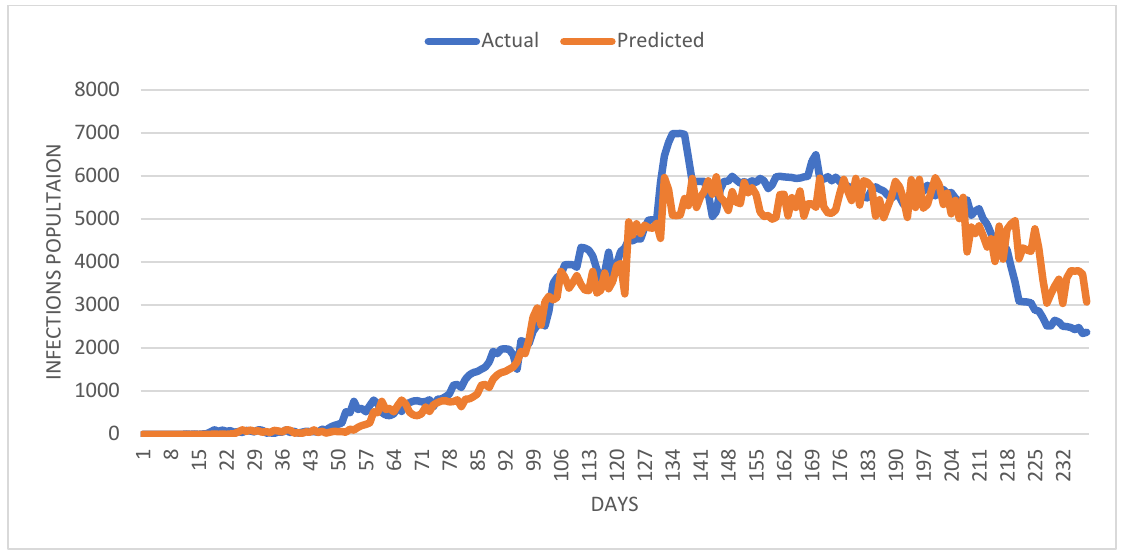
Fig.2. Future Predicted COVID-19 Curing rate by CO